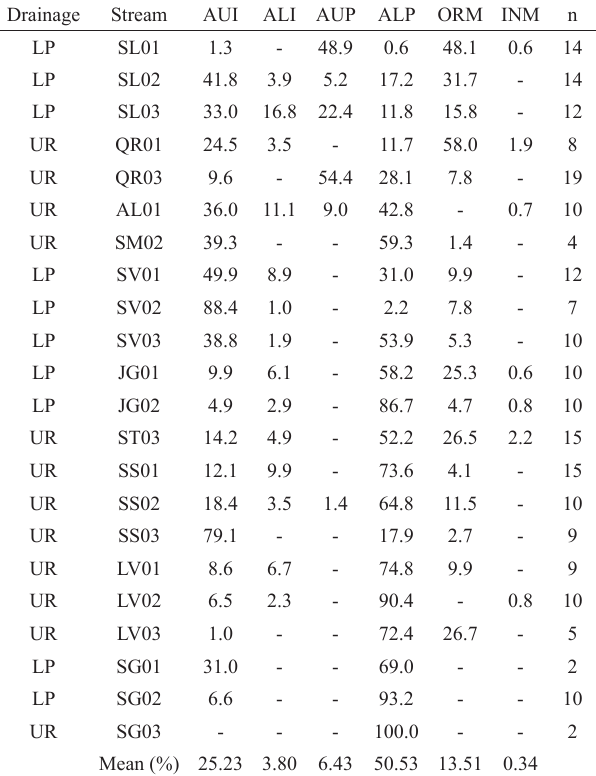
Tab. 2. The number of stomachs analyzed (n) and the food groups and their contribution by percentage of volume for the diet of Bryconamericus iheringii in the 22 streams and its respective drainages (Laguna dos Patos System – LP; Uruguay River basin – UR). AUI = autochthonous inverte - brates; ALI = allochthonous invertebrates; AUP = autoch - thonous plants; ALP = allochthonous plants; ORM = organic matter; INM = inorganic matter.